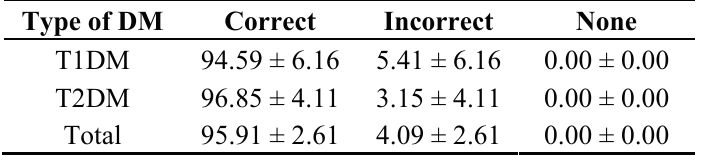
Table 11. Average accuracy (%) of the model for individual class and overall model.